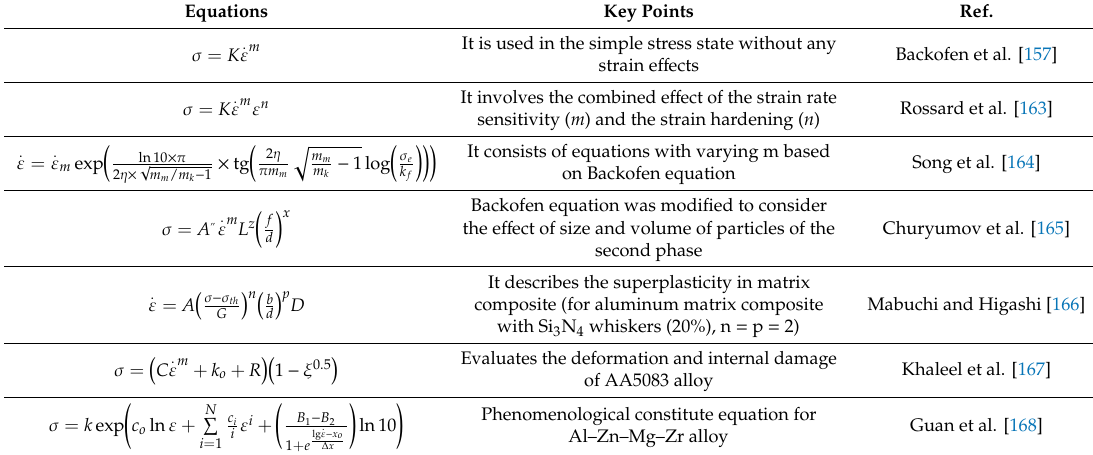
Table 2. Superplastic Constitutive